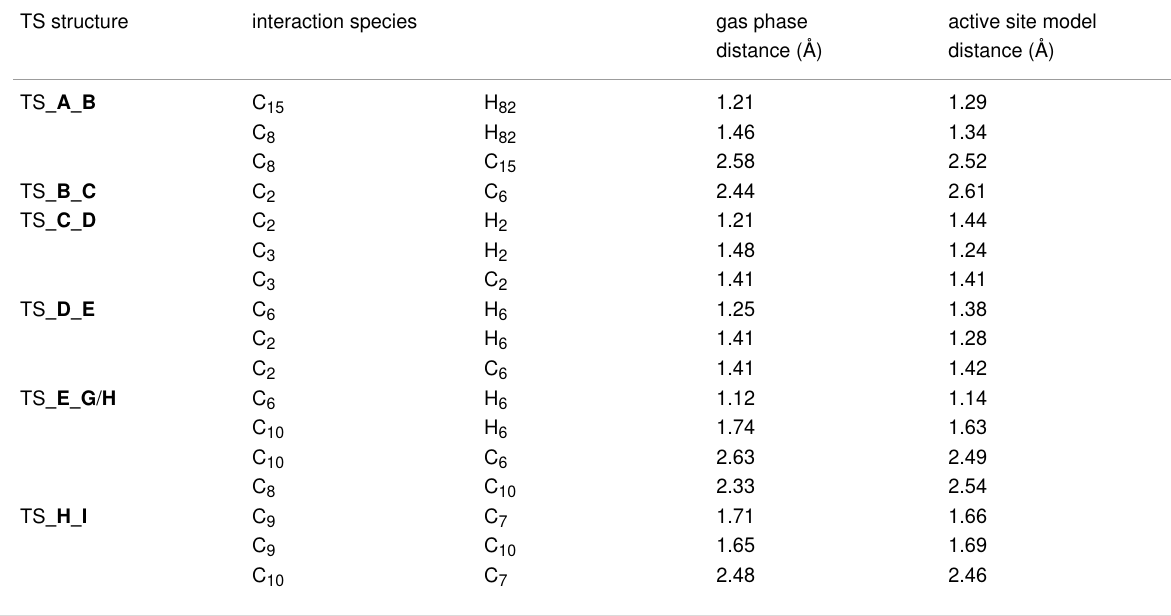
Table 2: Comparison table of transition state structures in gas phase vs active site model. TS